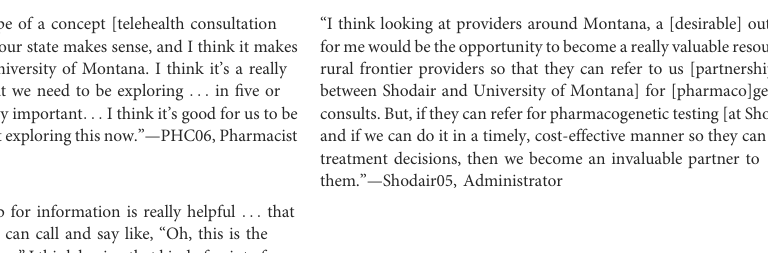
TABLE 6 Role of a unique telehealth delivery model for pharmacogenetic consultations. Confederated Salish and Kootenai Tribes